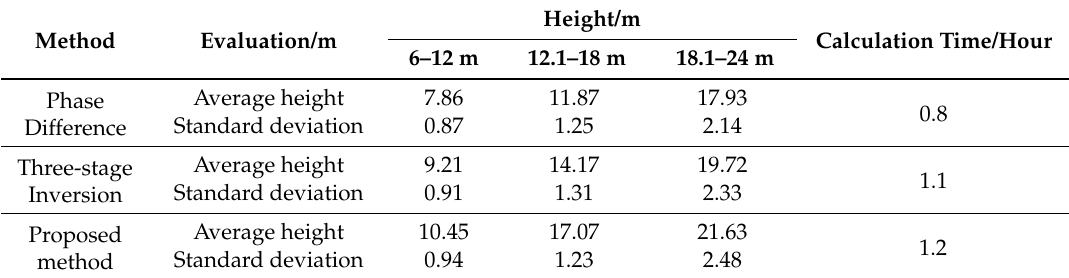
Accuracy results of different height estimation methods on BioSAR 2007 data set for